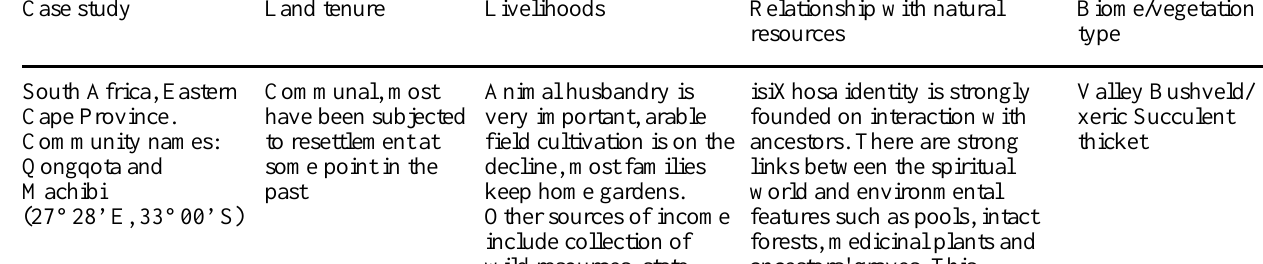
Table 1 . Case study profiles: South Africa and Peru. Case